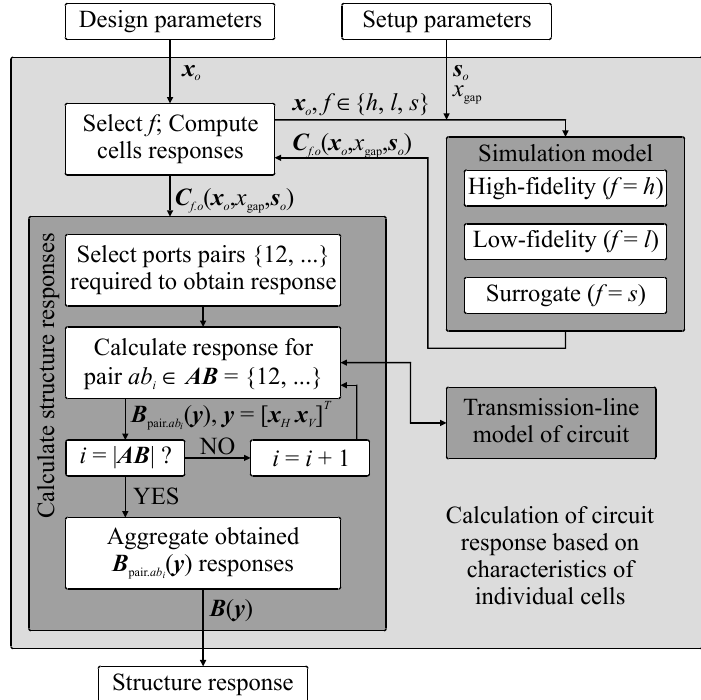
Figure 3. Calculation of structure responses (here, BLC) based on frequency characteristics of its building blocks. Note that all the steps enclosed in a light gray rectangle are controlled by the design framework of Section 3. Hence, the role of the user boils down to the choice of specifications and substrate-related parameters.